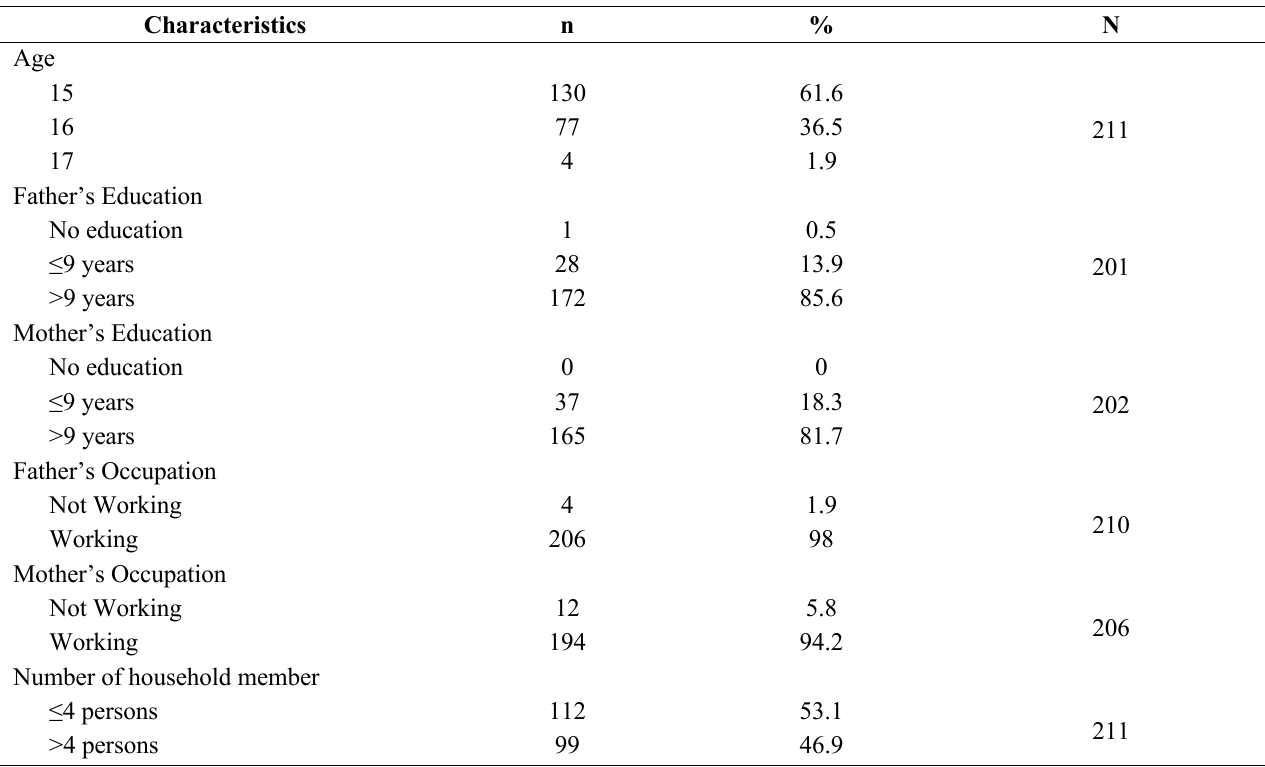
Table 1. General characteristics of the